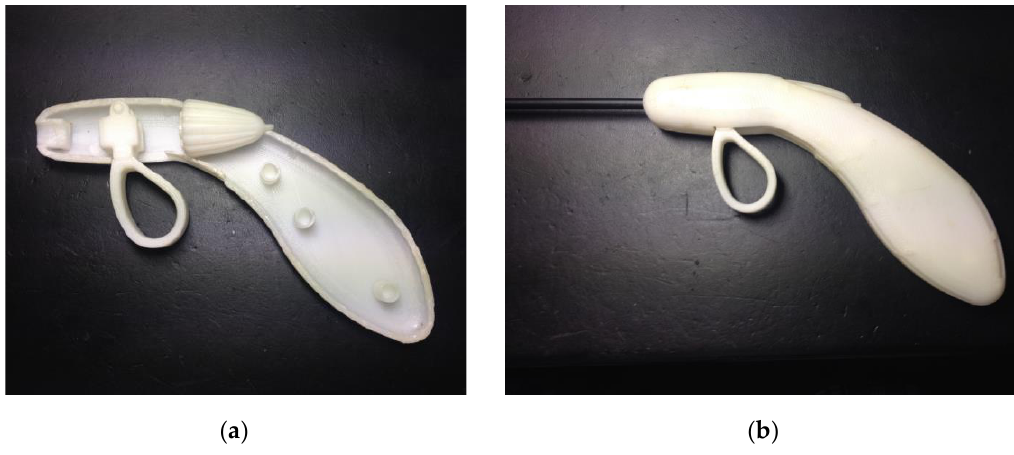
Figure 6. Prototype custom handle. ( a ) Details of the pieces; ( b ) assembled prototype.